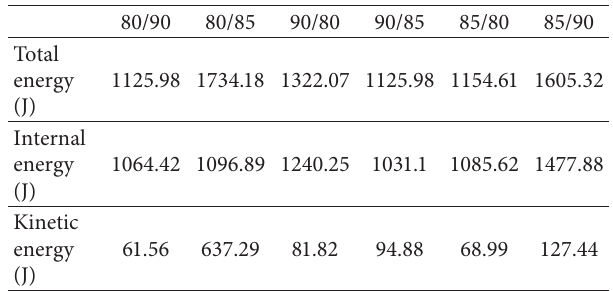
Table 6: Energy of aluminum foam in the lower